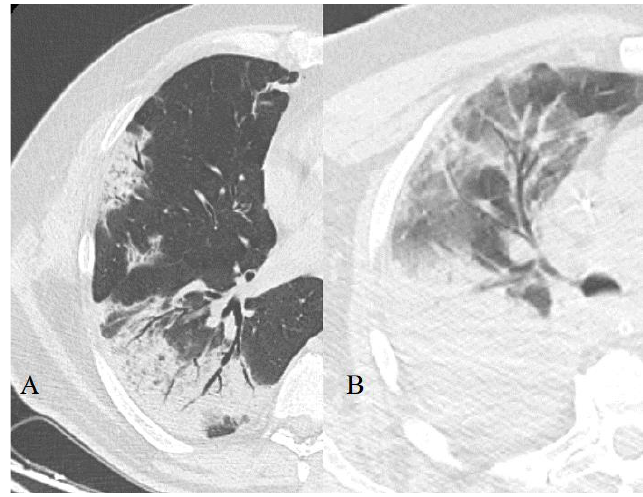
Figure 3. Consolidation with “ air bronchogram ” sign ( A ) or in a patient with Acute respiratory distress syndrome (ARDS) ( B ).